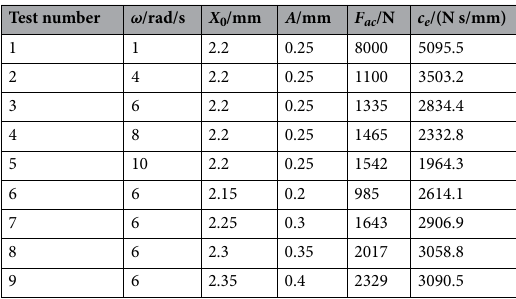
Table 1. Damping of the chain under different loading frequencies.